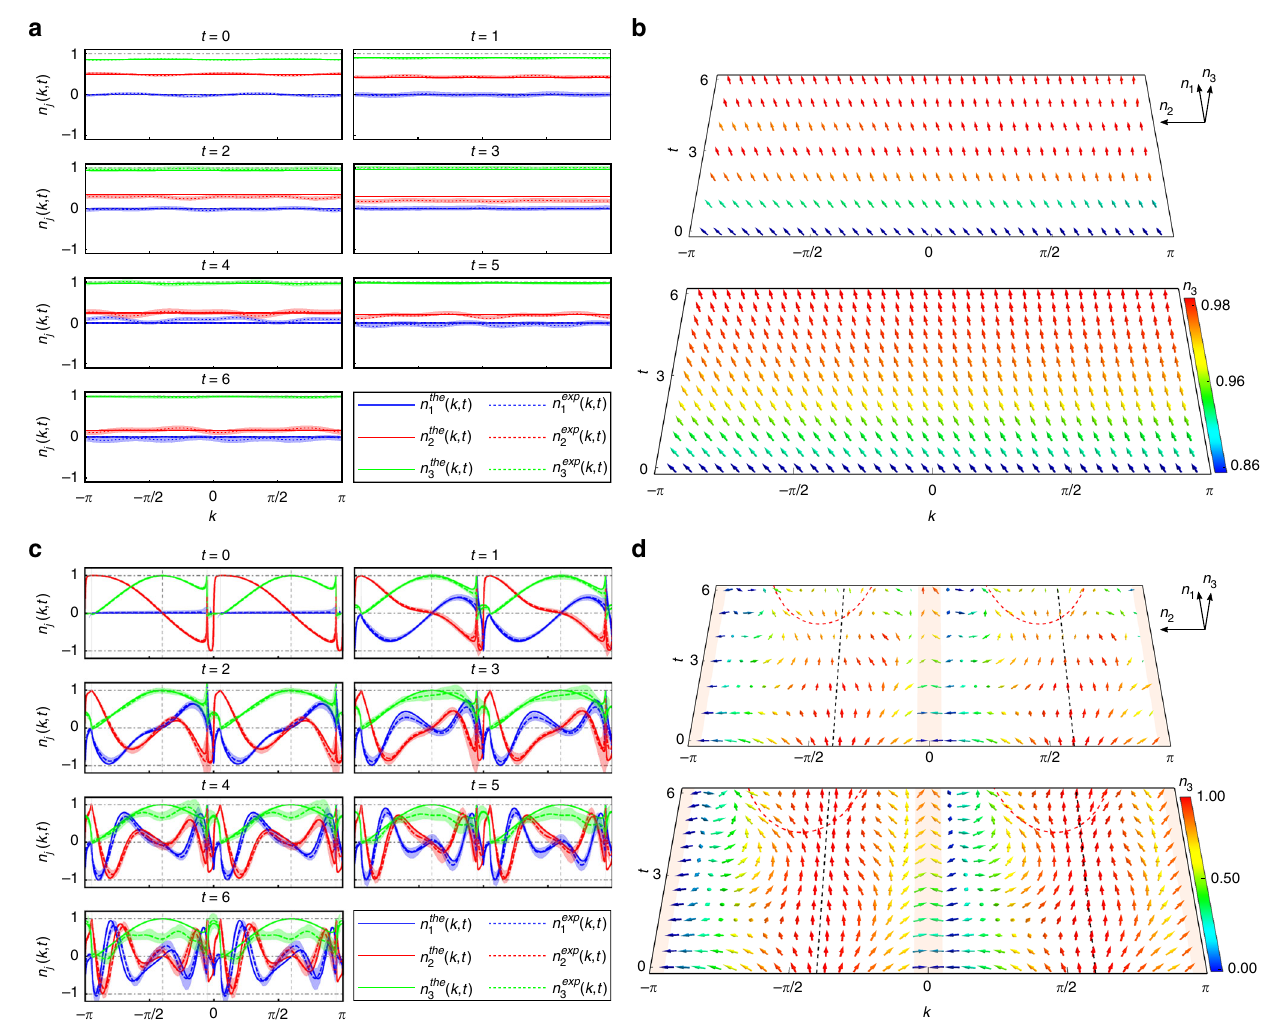
Fig. 6 Experimental results for the PT -symmetric broken QW dynamics. a Time-evolution and ( b ) spin textures of n ( k , t ) in momentum – time space for a ¼ π = 4 ; θ i ¼ (cid:3) π = 2 Þ and the fi nal PT -symmetry-broken Floquet operator quench process between the initial non-unitary Floquet operator given by ð θ i (cid:9) (cid:10)(cid:11) (cid:12) 1 2 ¼ (cid:3) π = 2 ; θ f ¼ 1 π (cid:3) arccos 1 given by θ f . The quasi-energy spectrum associated with U f is completely imaginary in this case. ( c ) Time-evolution and ( d ) α 1 2 2 spin textures of n ( k , t ) in the momentum – time space when the system is quenched from the same initial state as in Fig. 3b into a fi nal PT -symmetry- ¼ (cid:3) 0 : 39 π ; θ f ¼ 0 : 3864 π Þ with ν f = − 2. The quasi-energy spectrum associated with U f features purely imaginary broken Floquet operator given by ð θ f 1 2 [red shaded areas in ( d )] and purely real regions in momentum space. Only two fi xed points of the same kind exist at { − 0.4000 π , 0.6000 π } (dashed lines), whereas no skyrmion structures exist in any momentum – time submanifold. The spin vectors in ( c ) and ( d ) are colored according to n 3 ( k , t